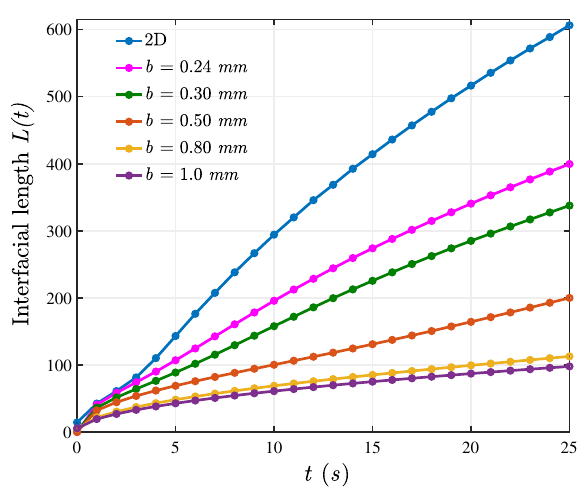
Figure 8. Interfacial length plots for M = 2, U = 5 mm/s . The 2 D curve corresponds to the results obtained by solving the Darcy’s law. Clearly, the three dimensional results approach the 2 D results with a decrease in the